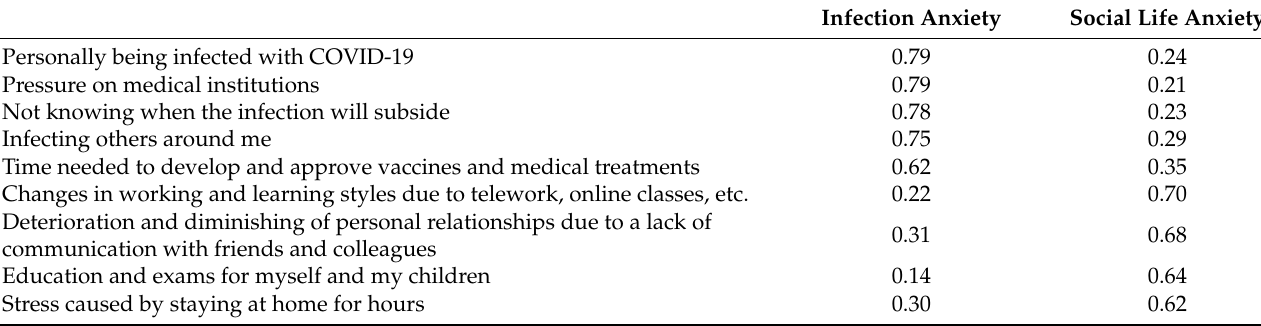
Table 2. Results of factor analysis regarding